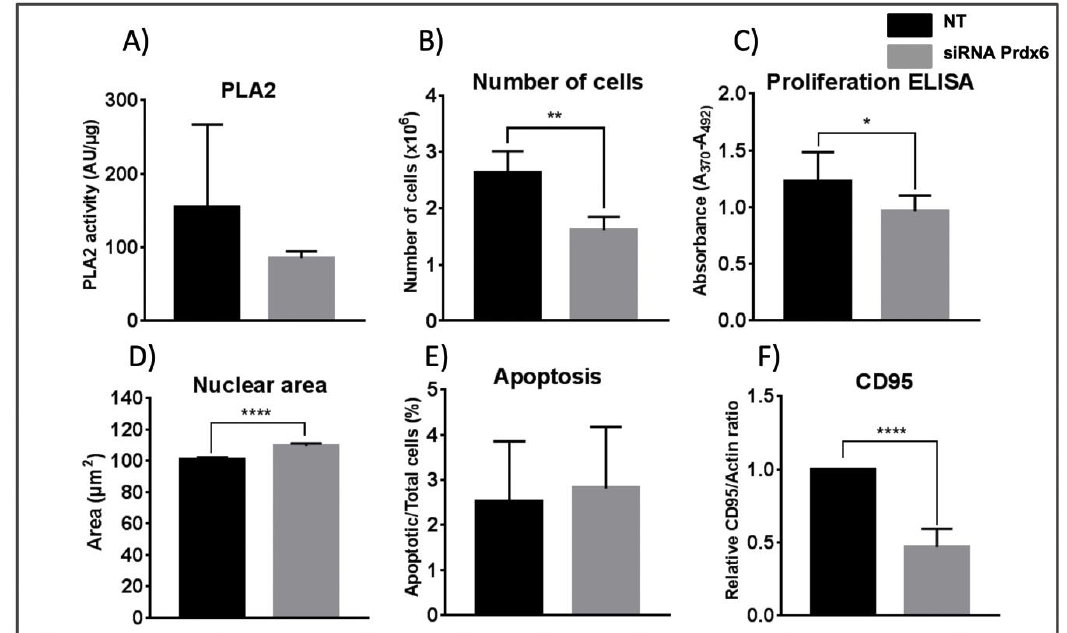
Figure 1. Effect of Prdx6 silencing on PLA2 activity, cell viability, nuclear area, apoptosis, and CD95 level. ( A ) Prdx6-dependent PLA2 activity was determined, as described in Materials and Methods, in cell lysates of HepG2 cells treated with siRNA-Prdx6 or with non-target siRNA (NT) as indicated. Activity is expressed as arbitrary fluorescence units normalized for protein content. Data are the mean of 5 independent biological replicates. ( B ) The number of cells determined as indicated in M&M. ( C ) Proliferation in terms of cells entering the S phase was determined by the degree of BrdU incorporation to replicating DNA and expressed in absorbance units. ( D ) The nuclear area of cells was determined as indicated in M&M. >500 cells were measured, from 6 different slides, in each sample. The area is given in arbitrary units. ( E ) Apoptosis was determined by the Annexin V fluorescence method; the number of positive cells relative to the total number of cells in percentage is represented. ( F ) CD95 levels were determined by western blotting with specific antibodies and band density was normalized to the signal for actin. Parameters in (B), (C), (E) and (F) were determined in three independent experiments; error bars show SD; statistical significance was assessed by Student’s T-test and is shown with a number of asterisks inversely proportional to the p-value (**** < 0.0001, ** < 0.01, * < 0.05).